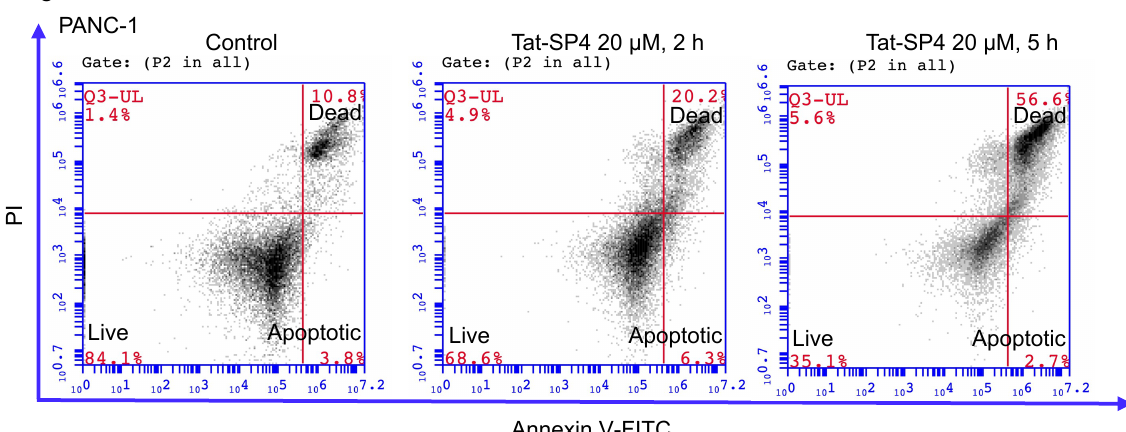
Figure 4. Tat-SP4 induced predominantly non-apoptotic cell death. Flow cytometry analysis with Annexin V FITC-PI staining was performed in BxPC-3 cells ( A ), MIA PaCa-2 ( B ) and PANC-1 ( C ) cells, respectively, after treatment of the indicated peptides for the indicated times. The percentage of dead cells (PI positive) in Tat-SP4 treatment groups was significantly increased compared with that of control, without notable changes in the population of apoptotic